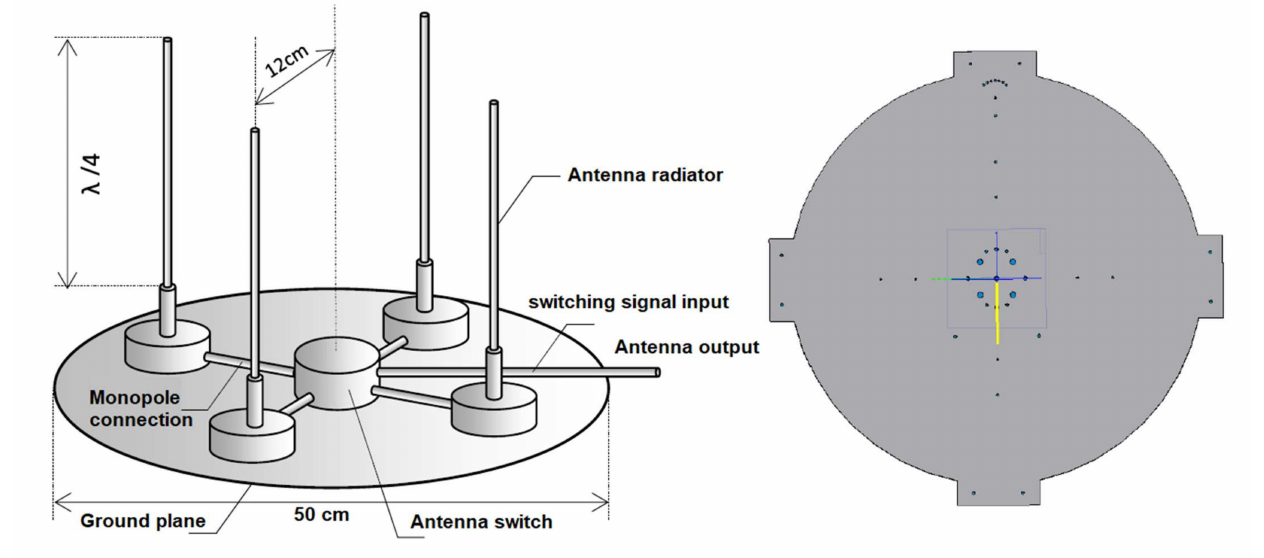
Figure 7. Model design of the antenna system and ground plane of the IDVOR targeting device. The monopole is based on a supporting frequency of 430 MHz and tuned to its resonance. Each of the four monopoles is adapted with a 1 k Ω resistor connected in parallel between the monopole and the artificial ground. This is due to adjusting the output impedance to 50 Ω and for the discharge of any static